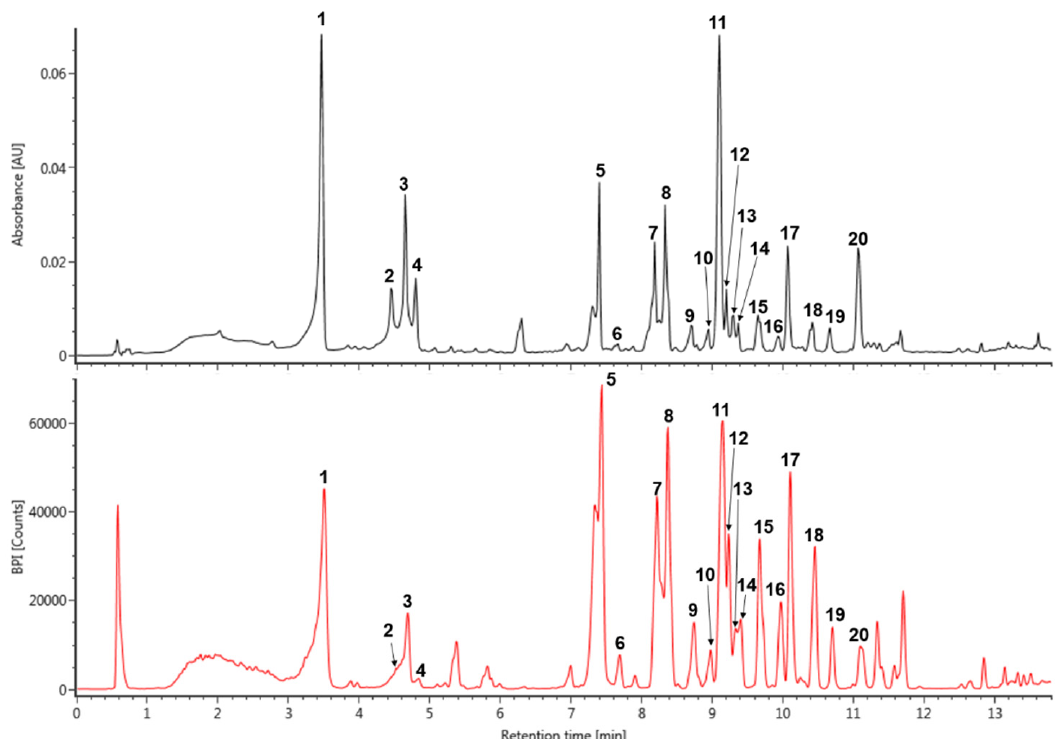
Figure 1. The UV (280 nm) and base peak intensity (BPI) chromatogram of Spiraea prunifolia var. simpliciflora in negative mode using ultra-performance liquid chromatography-quadrupole-time of flight mass spectrometry (UPLC-QToF-MS). Table 1. Tentatively identification of major peaks detected in Spiraea prunifolia var. simpliciflora. No.